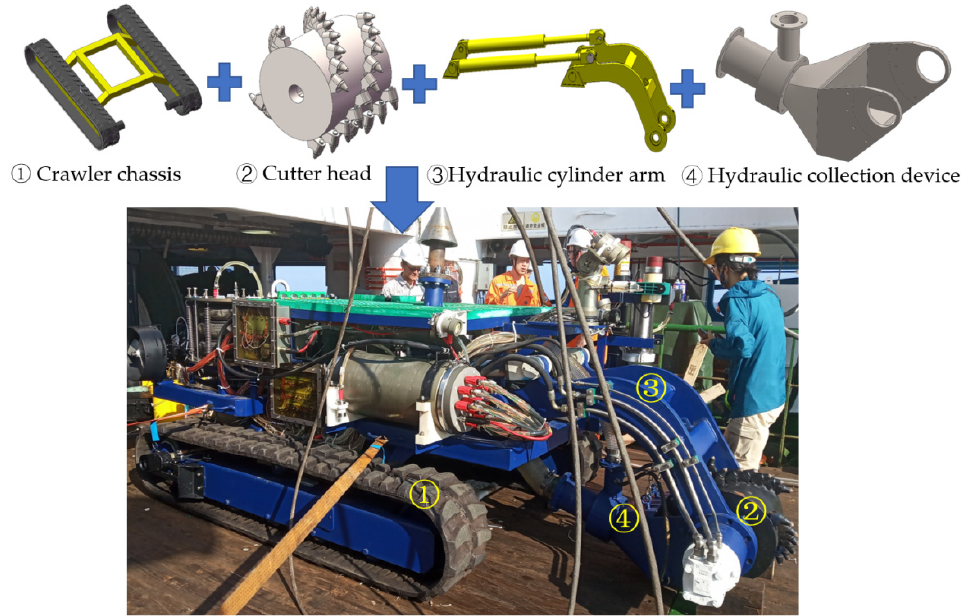
Table 1. Essential parameters of the mining vehicle.